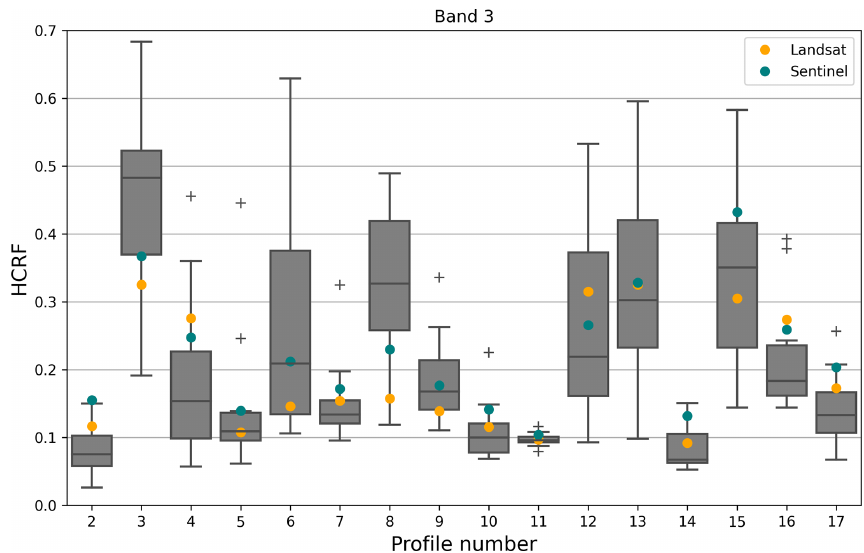
Figure 7. Spread of the Sentinel band-3 (wavelength range: 542.5–577.5nm) mean values of the measured spectra, grouped by profile. Orange and teal circles show corresponding mean pixel values of data extracted from Landsat and Sentinel pixels at the sampling sites of the spectra, respectively. The boxes represent the first and third quartile. The whiskers represent 1.5 × the interquartile range; the + symbols are outliers.